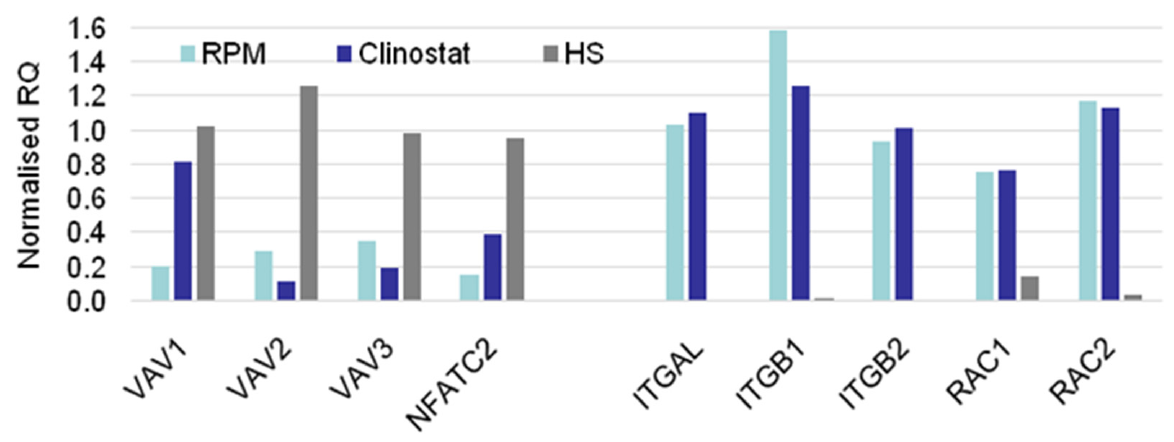
Figure A2. Gene Ontology (GO) enrichment analysis. Treatment versus control comparison for: ( A ) Cellular component (CC), ( B ) molecular function (MF), and ( C ) biological processes (BP) terms. * denotes significantly enriched GO terms. Top 20 significantly enriched GO terms are shown.